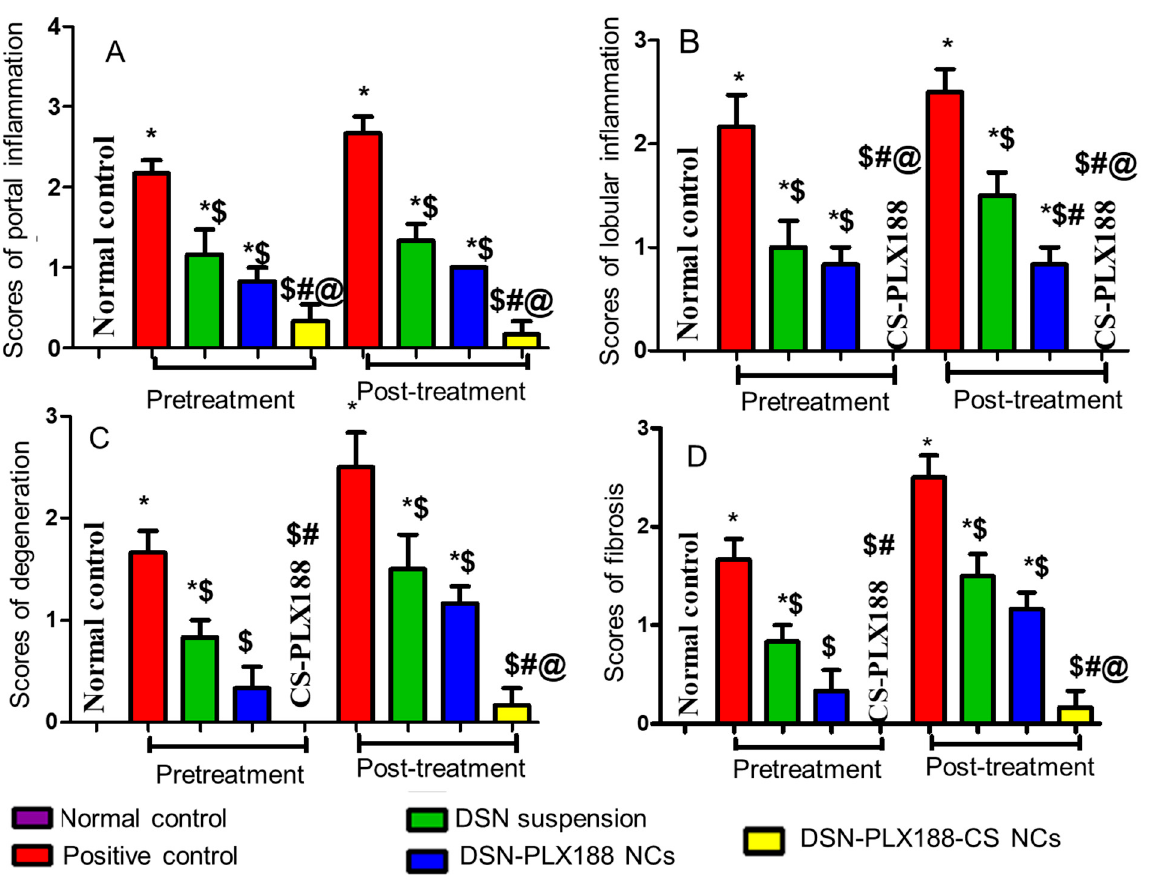
Figure 9. Statistical analysis of the histopathological alterations of the hepatic sections of the different groups following the pretreatment and the post-treatment regimens. ( A ) Portal inflammation, ( B ) Lobular inflammation, ( C ) Degeneration and ( D ) Fibrosis. Data are expressed as the mean ± SD. The statistical analysis was performed at p < 0.05. *, $, #, and @ indicate significant differences. * vs. the normal control. $ vs. the positive control. # vs. DSN-treated group. @ vs. DSN–PLX188-NC-treated group.